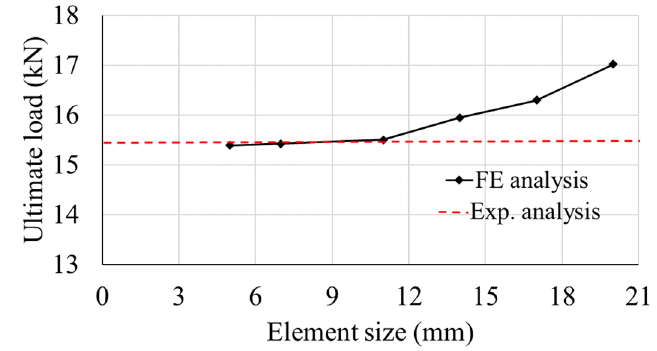
Figure 7. Mesh convergence study of the two-way deck.